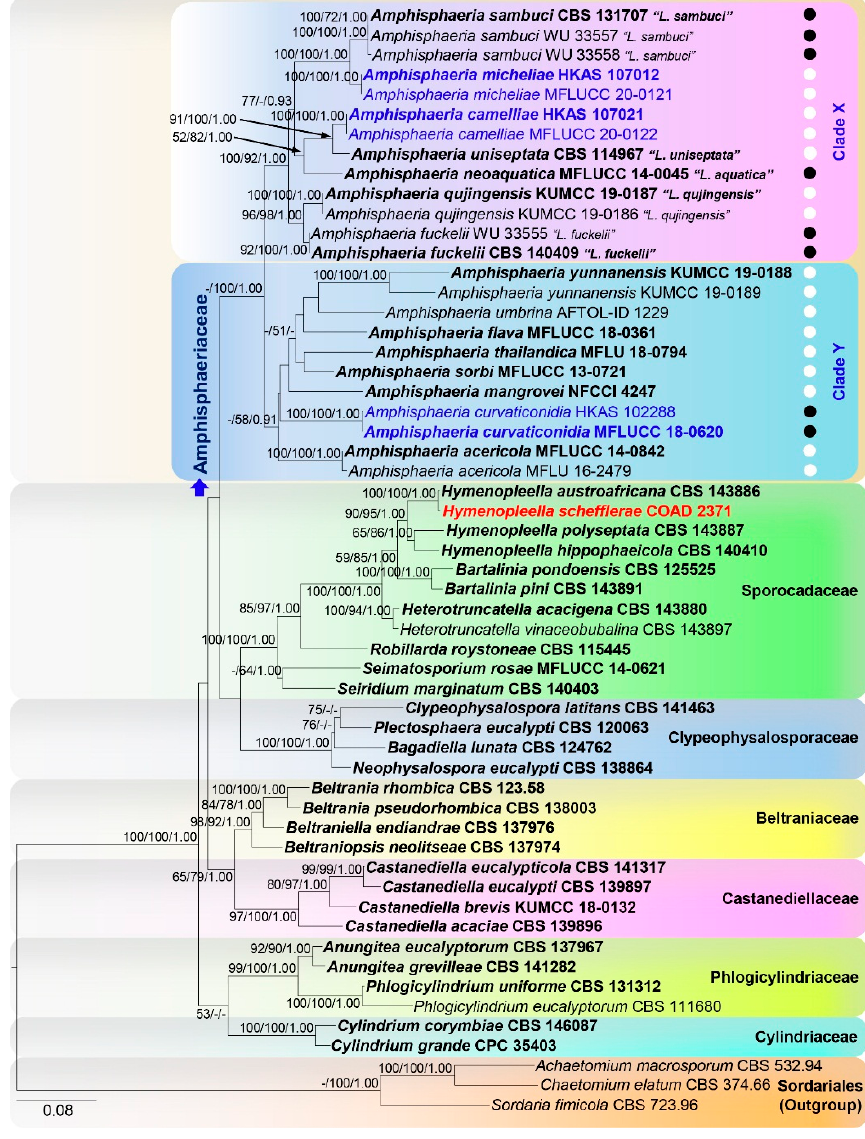
Figure 1. ML tree revealed by RAxML from an analysis of the LSU-ITS-RPB2-TUB2 matrix of the Amphisphaeriaceae and selected families of Amphisphaeriales. Bootstrap supports ( ≥ 50%) of MP and ML and the posterior probability values ( ≥ 0.9) of BI analyses are indicated above or below the respective branches. Newly generated sequences are in blue and type strains are in bold. The tree is rooted to Achaetomium macrosporum , Chaetomium elatum, and Sordaria fimicola (Sordariales). The scale bar represents the expected number of nucleotide substitutions per site. Ascospore septation among taxa are shown in white (one septum) and black (more than one septum) circles. Taxon in red denotes topological conflict with previous phylogenies. Previous taxa are in “ • ”.